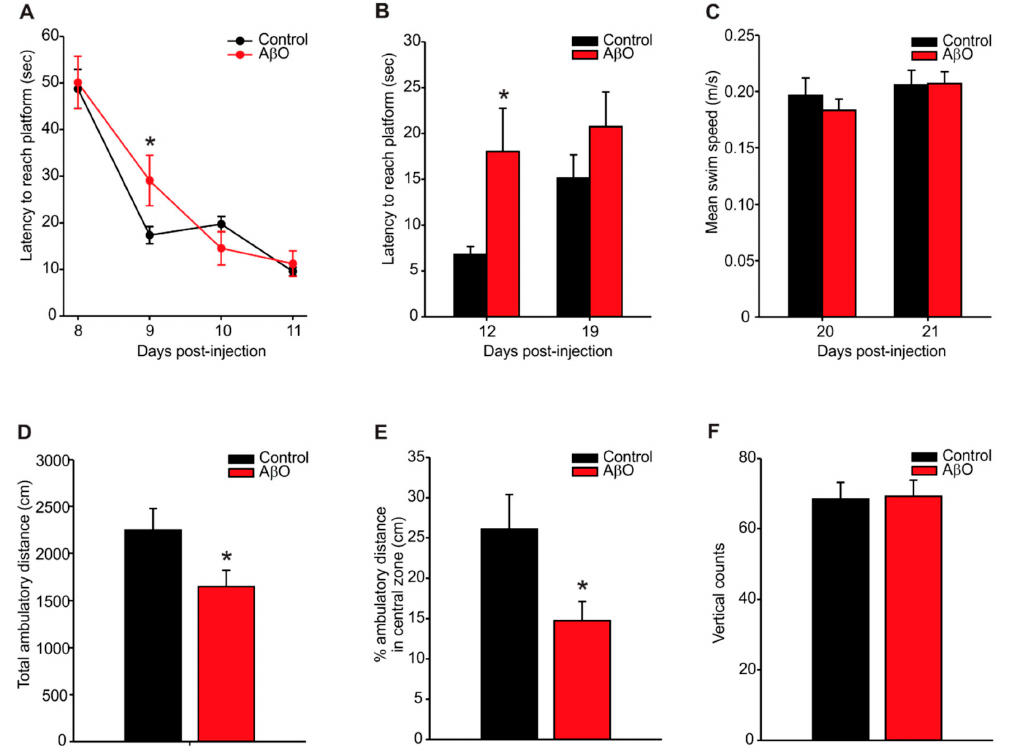
Figure 1. Behavioural assessment using the Morris water maze ( A – C ) and open field tasks ( D – F ). ( A ) Latency to reach platform was measured on post-surgical days 8–11 to assess initial learning of the task. A β O-injected rats took significantly longer to reach the platform on day 9 compared to control rats; ( B ) probe trials were performed on days 12 and 19 to assess memory. A β O-injected rats took significantly longer to reach the platform on day 12 compared to controls; ( C ) mean swim time indicated no differences in swim speed between A β O-injected and control rats; ( D ) A β O-injected rats showed significantly less ambulatory time compared to controls in the open field task; ( E ) A β O-injected rats spent significantly less time in the central zone compared to control rats; ( F ) no differences in motor ability detected using vertical counts between A β O-injected and control